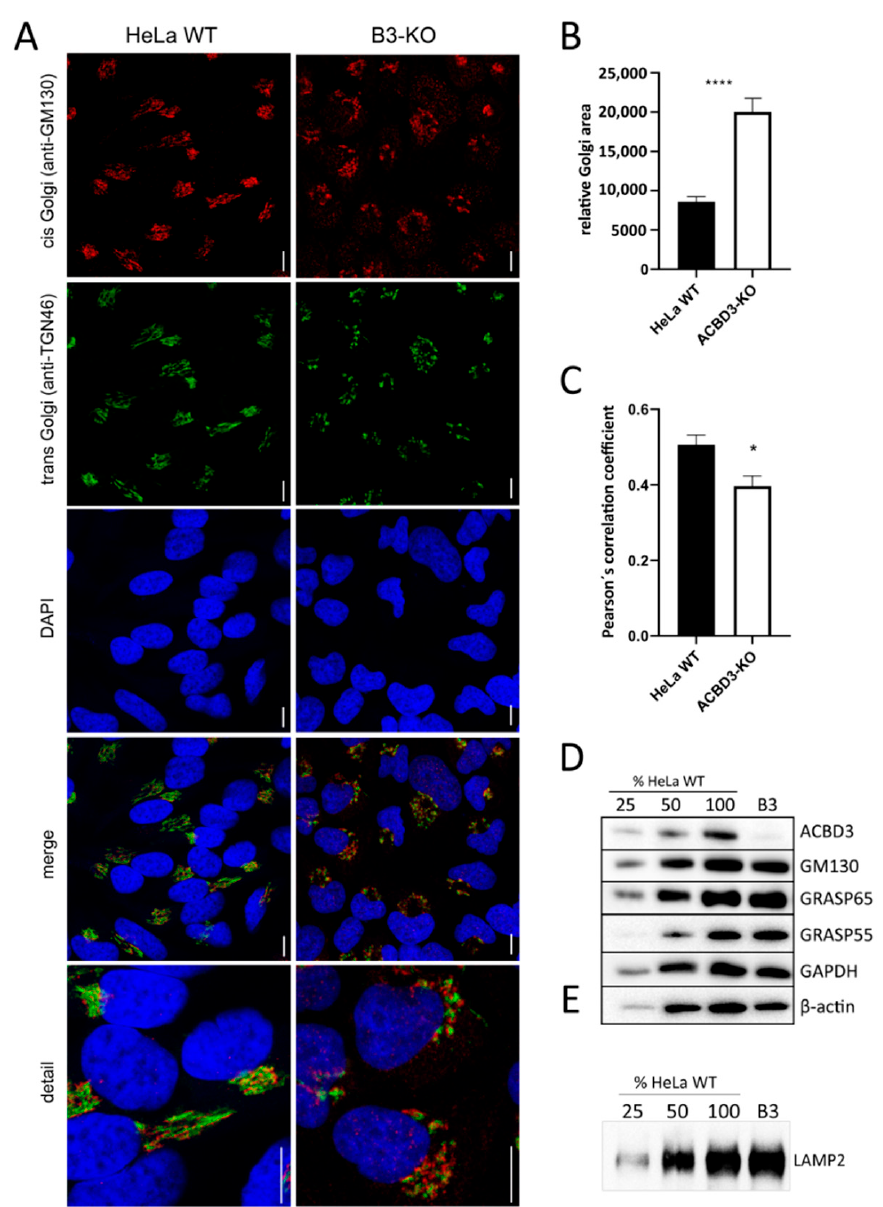
Figure 3. Golgi assessment in ACBD3-KO cells. ( A ) Confocal immunofluorescence images of cis- (GM130) and trans-Golgi markers (TGN-46) in HeLa WT and ACBD3-KO. In ACBD3-KO, Golgi